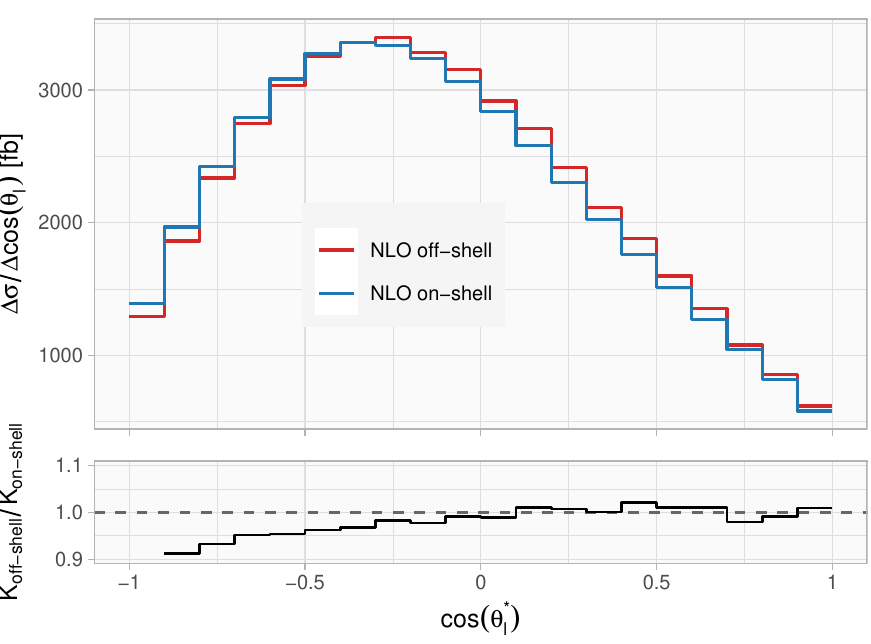
Figure 18. Distribution of cos (cid:18) (cid:3) at NLO in the on-shell approximation and for an o(cid:11)-shell top l quark. The lower panel shows the ratio of the o(cid:11)-shell and on-shell K -factors. Note the range of the y -axis, which does not start at zero.